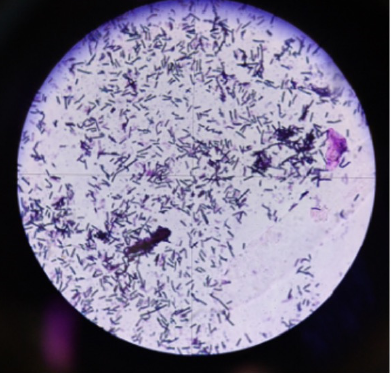
Figure 3. Gram-positive spore-forming rods.